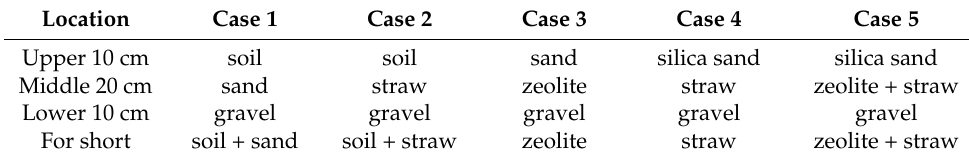
Figure 1. ( a ) Test device. ( b ) Structure of improved subsurface drainage. Figure 1. ( a )Test device. ( b ) Structure of improved subsurface drainage. Table 1. Materials in different test Table 1. Materials in different test cases.